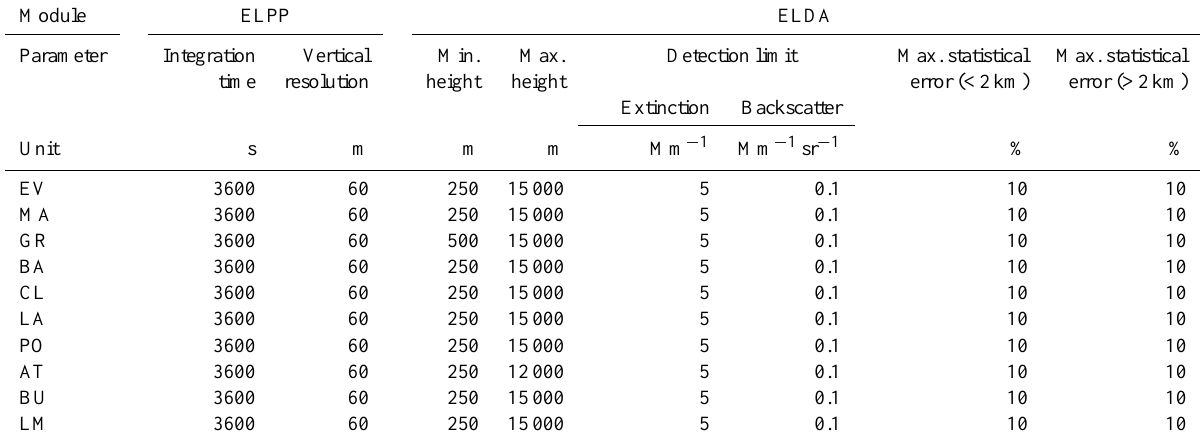
Table 2. General parameters of the SCC product configuration set up for the exercise. Module ELPP ELDA Parameter Integration Vertical Min. Max. Detection limit Max. statistical Max. statistical time resolution height height error (<2km) error (>2km) Extinction Backscatter